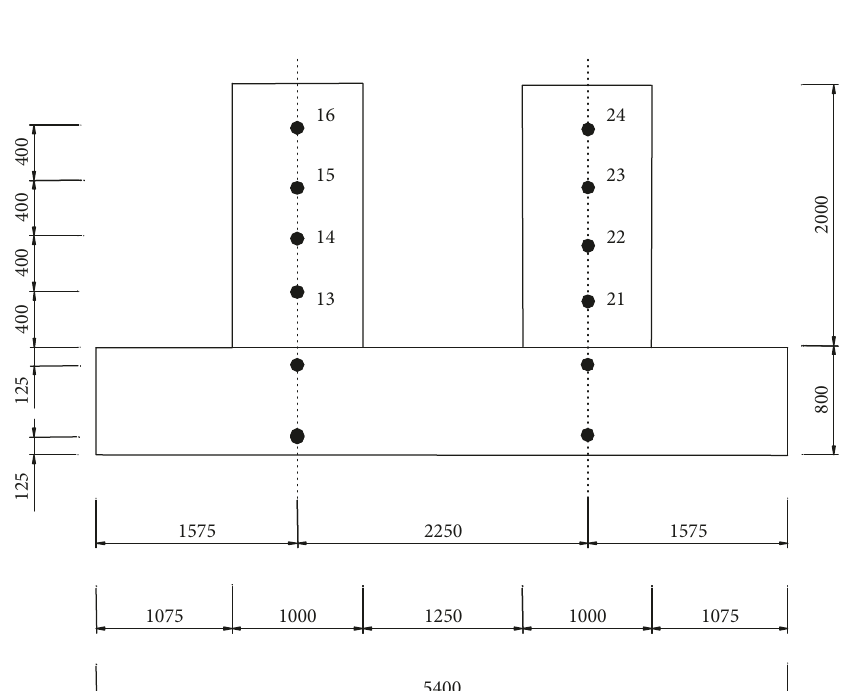
Figure 1: Field test.